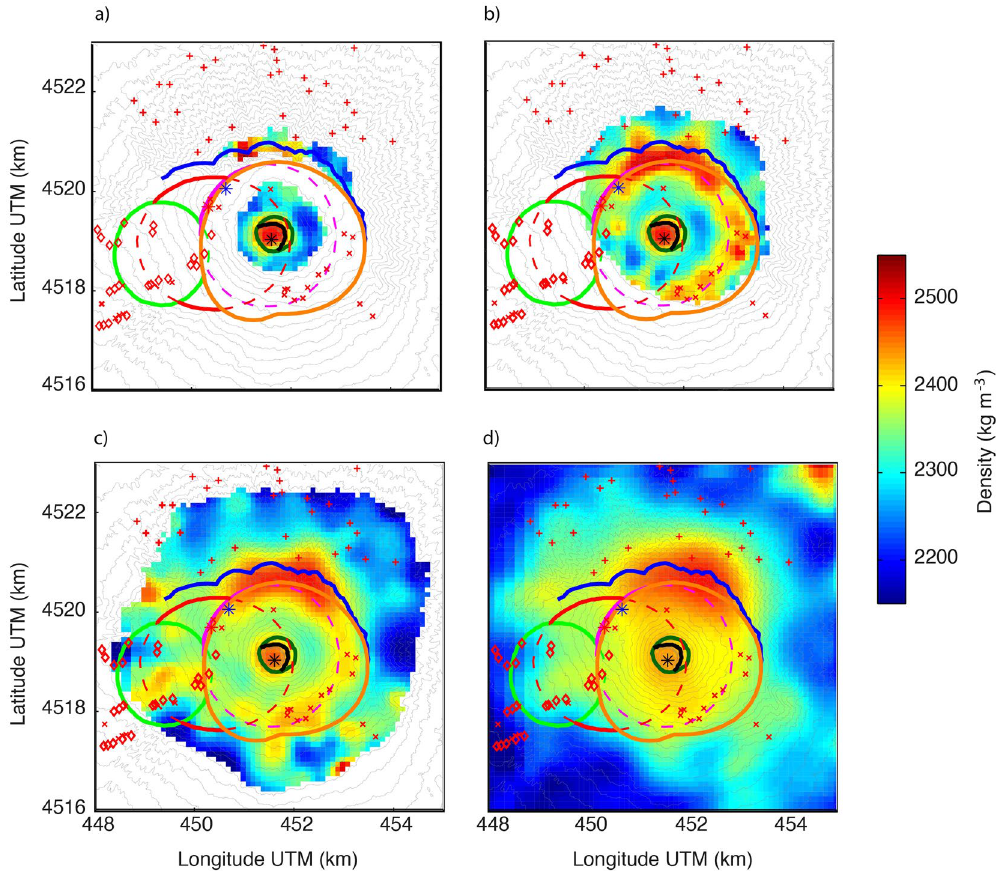
Figure 5. Horizontal slices of the 3-D density model at different altitudes with respect to the sea level: ( a ) 950 m, ( b ) 750 m, ( c ) 450 m and ( d ) − 50 m. The overlain geological features are detailed in Fig. 1. The maps were created using Matlab (version R2013b;